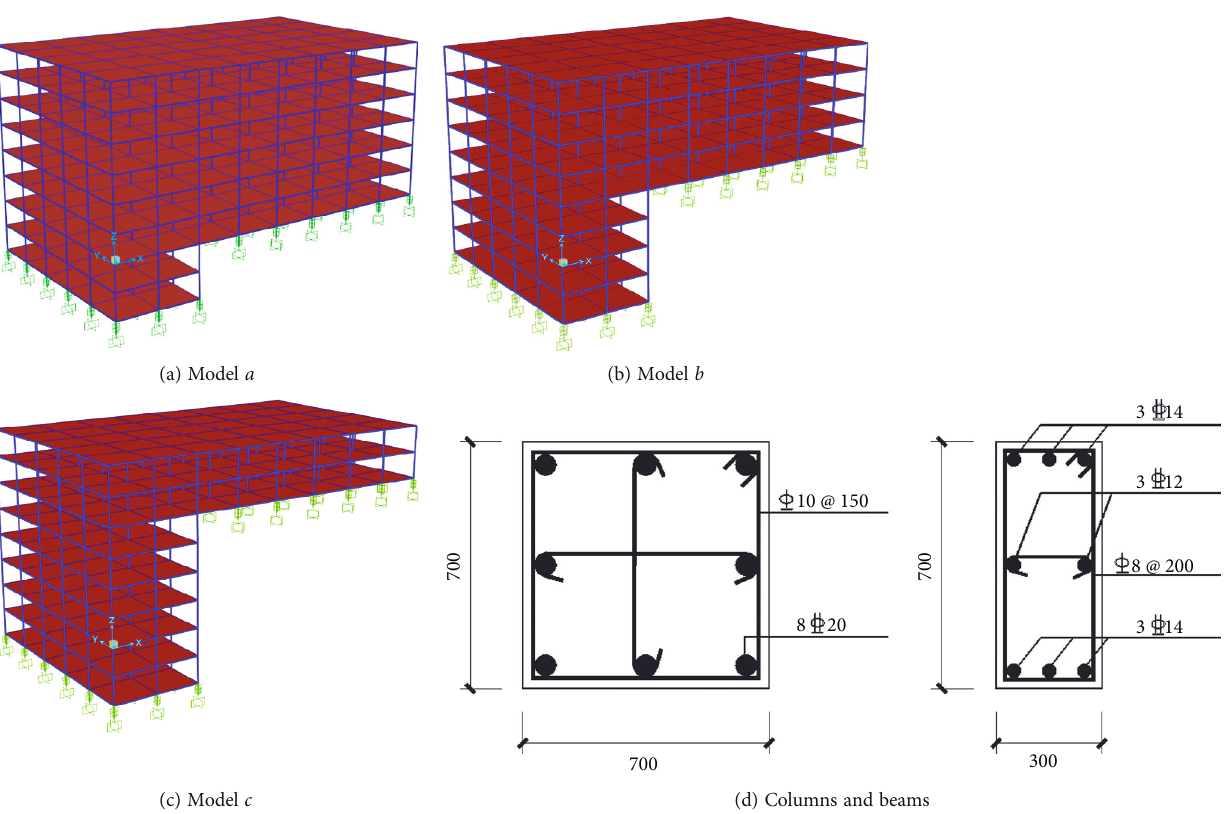
Figure 2: Structural model and reinforcement